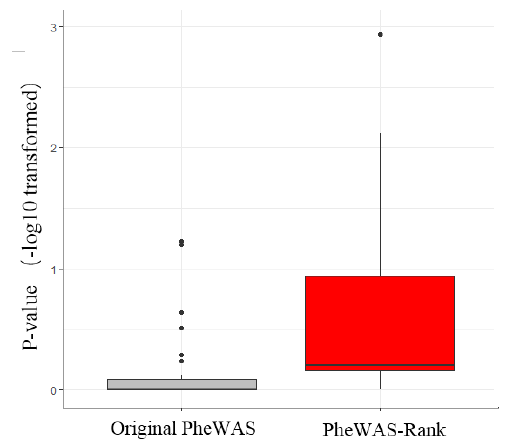
Figure 5. The original PheWAS top 100 gene list and PheWAS-Ranked top 100 gene list was validated with a Kolmogorov–Smirnov test using 63 known anti-breast cancer active drugs.